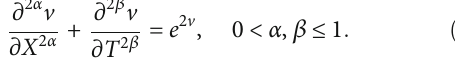
= − 0 : 5 , 0 Figure 4: 3D graph of V = 1 represent the exact traveling wave solutions. and z 1